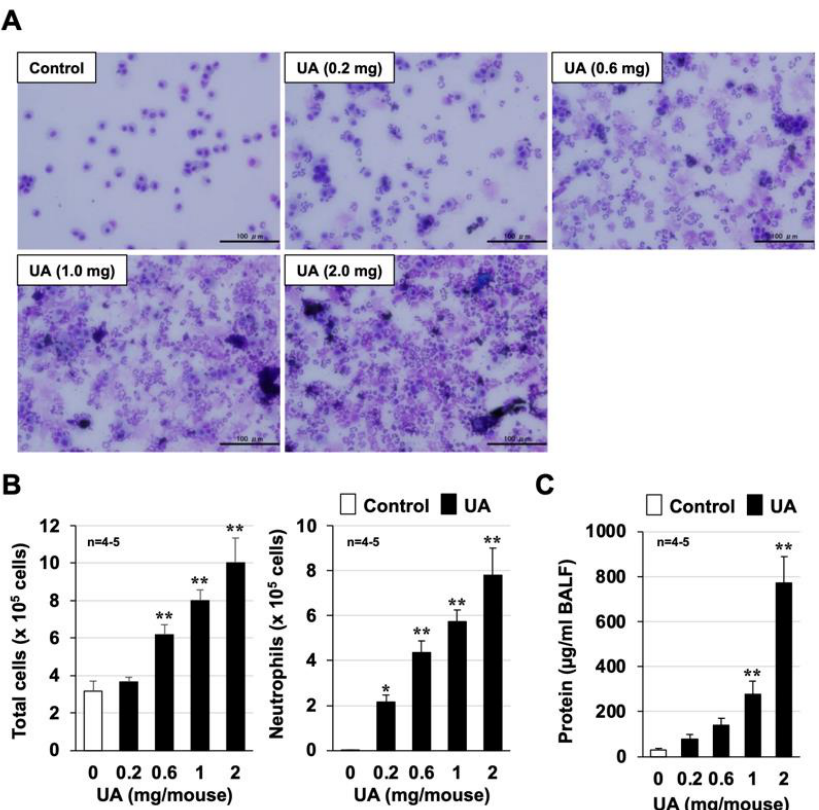
Figure 1. Urban aerosol-induced lung injury. Male ICR mice were intratracheally administered an an urban aerosol particle suspension (0.2–2.0 mg/mouse) or sterile saline (Control). BALFs urban aerosol particle suspension (0.2 – 2.0 mg/mouse) or sterile saline (Control). BALFs were pre- pared 24 h after the intratracheal administration. ( A ) BALF cells were deposited onto slides using a Cytospin 4 cytocentrifuge, then stained with Diff-Quik reagents and visualized under a light micro- scope (scale bar, 100 µm). ( B ) The numbers of total cells and neutrophils were determined. ( C ) The amount of protein present in the BALF was determined by the Bradford method. Values are ex- pressed as the mean ± SEM; * p < 0.05; ** p < 0.01. (* vs. Control).